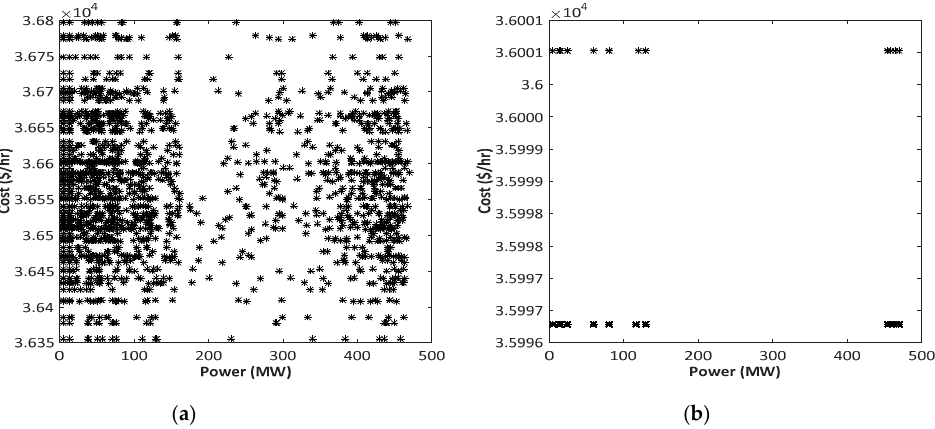
Figure 14. Bats positions in the dBA ( a ) before and ( b ) after 1000 iterations (15-unit system with renewables).